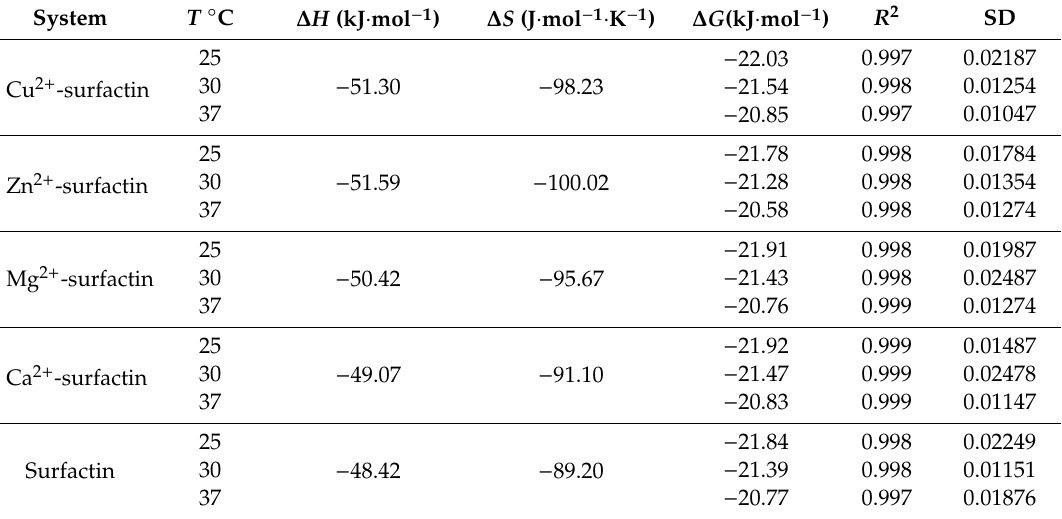
Table 4. Thermodynamic parameters for the binding of surfactin and metal-surfactin complexes to BSA.